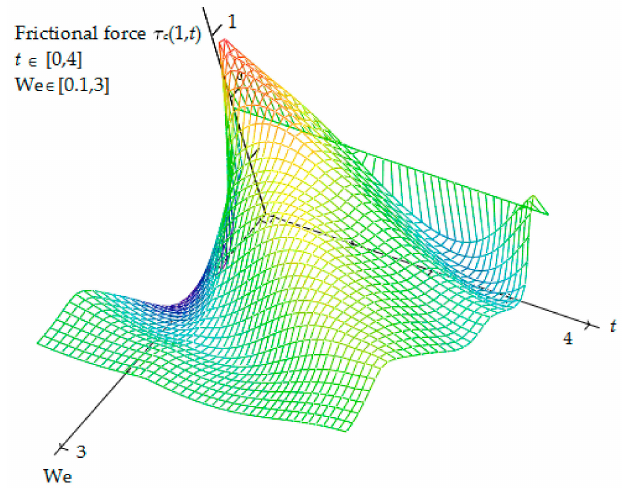
Figure 4. Profiles of the transient velocity u ct ( y , t ) versus t , for three different values of pressure– viscosity parameter β at ( a ) y = 0.4, We = 0.5, and ( b ) y = 0.4, We = 0.75. The variation of the frictional force per unit area τ c ( 1, t ) exerted by the fluid on the upper plate is presented in Figure 5 when the time t and the Weissenberg number We vary in the intervals [ 0, 4 ] and [ 0.1, 3 ] , respectively.